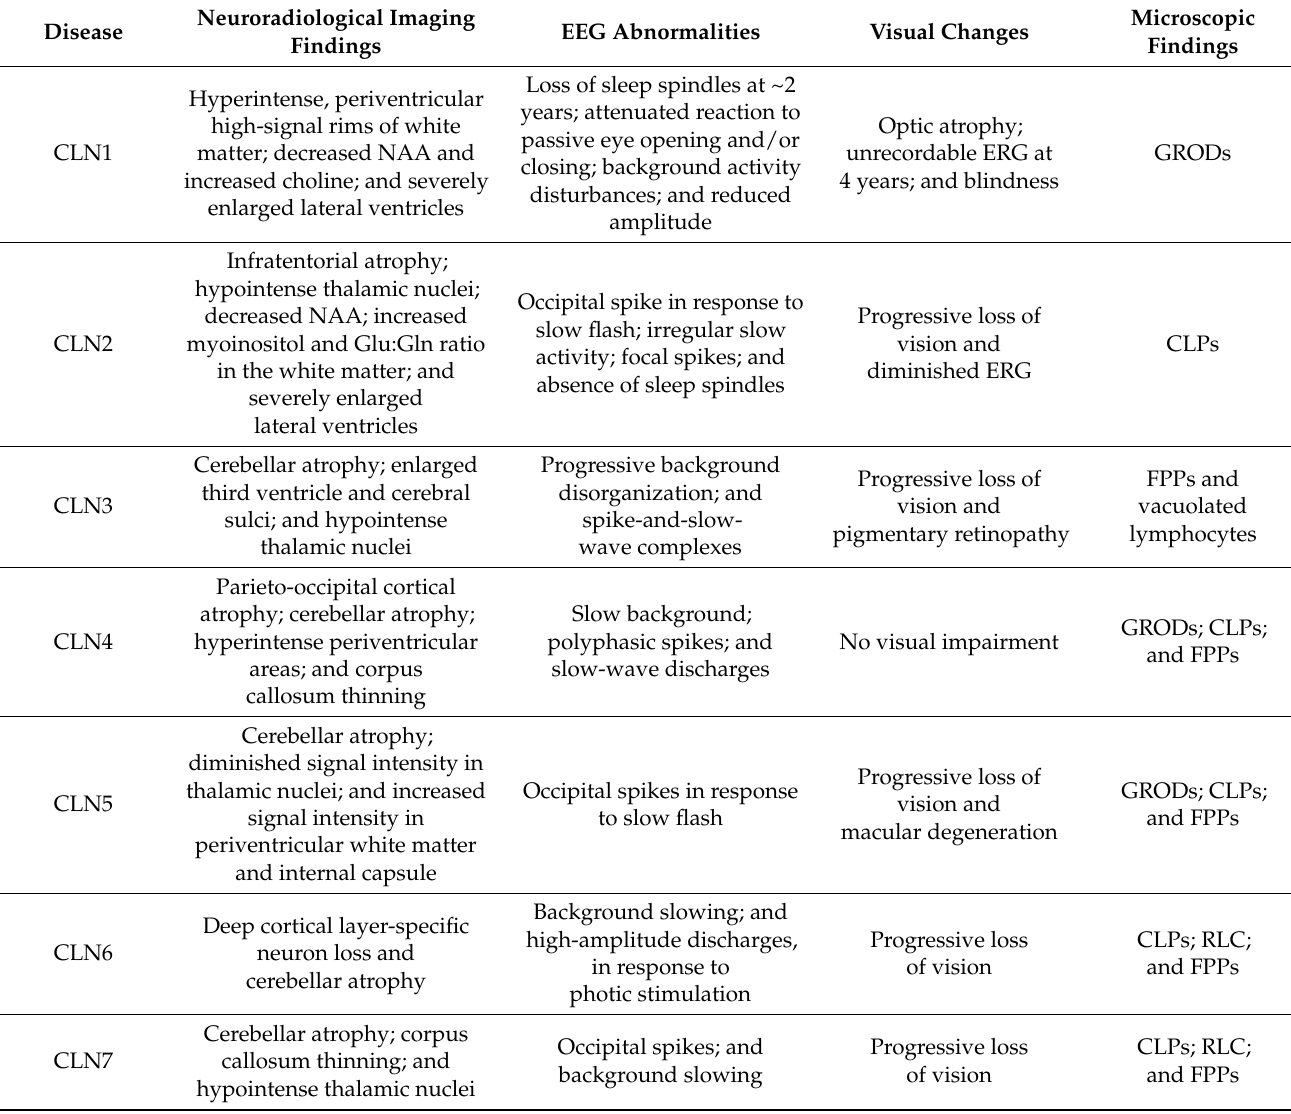
Table 4. NCL subtypes and abnormalities in diagnostic test results [3,4,16,20]. Neuroradiological Imaging EEG Abnormalities Visual Changes Disease